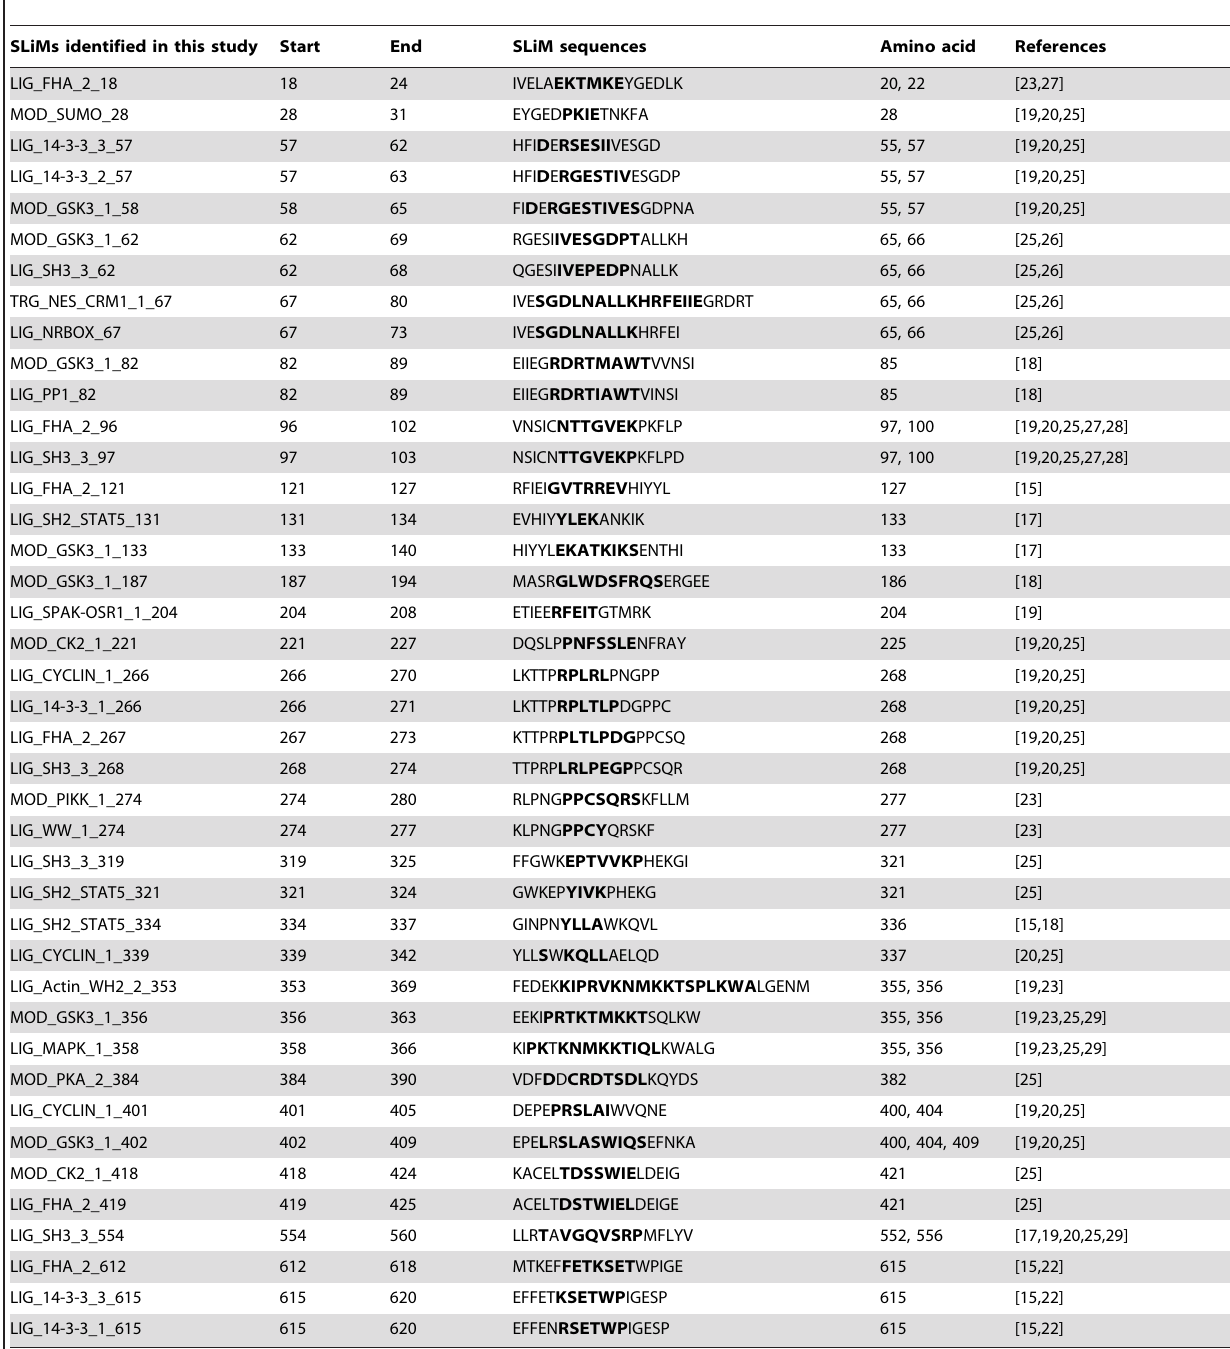
Table 2. SLiMs mapped to the vicinity of amino acids that were reported as genetic signatures or are associated with the adaptation of IAV PA proteins to the